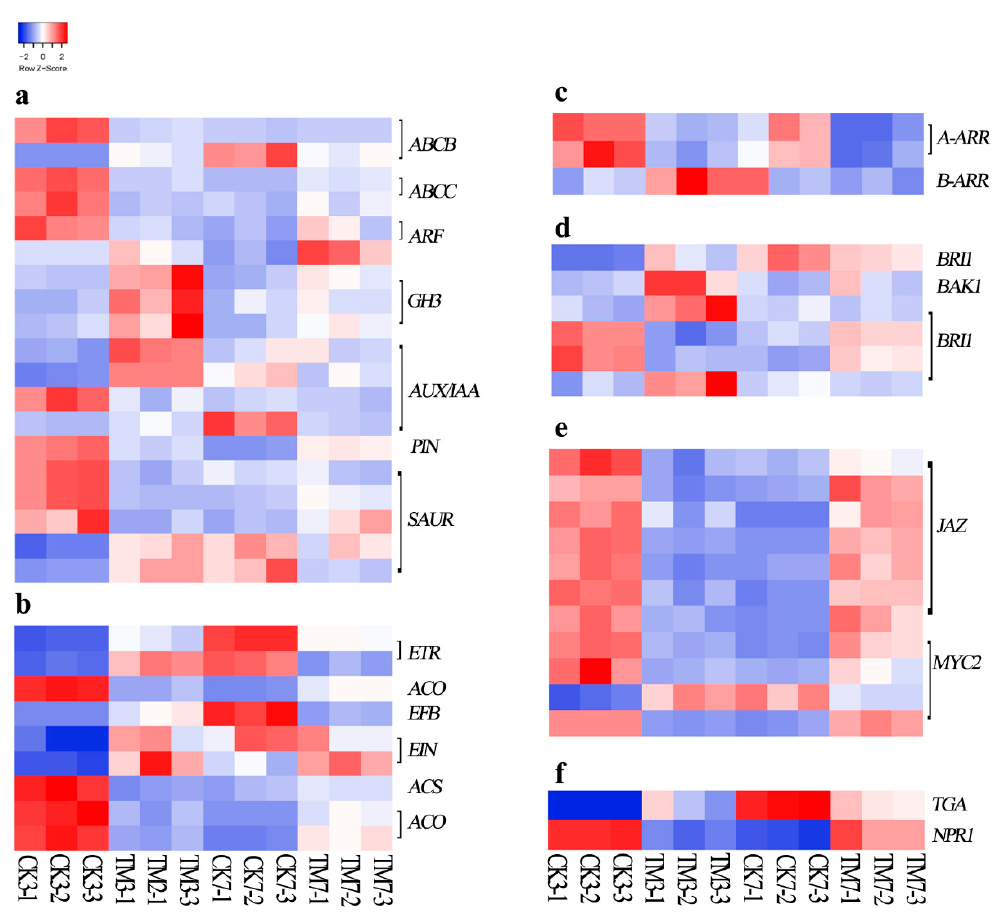
Figure 3. Heat map of genes involved in plant hormone transduction pathways. ( a ) Auxin, ( b ) ethylene, ( c ) cytokine, ( d ) brassinosteroid, ( e ) jasmonic acid, and ( f ) salicylic acid. The color key represents log2-transformed fold changes: red indicates high expression, and blue represents low expression. Heat map representing transcripts per million (TPM) expression from RNA-seq. The Z-score scale is shown in the top-left corner, and it ranges from red to blue.